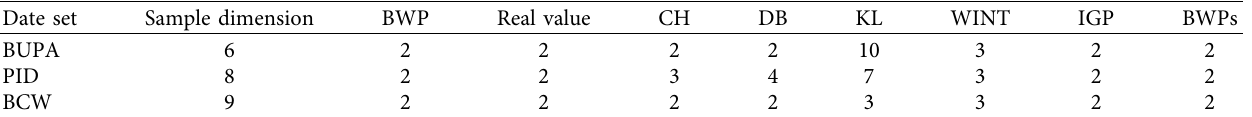
Table 3: The best clustering number of the UCI data set estimated by several validity evaluation indexes